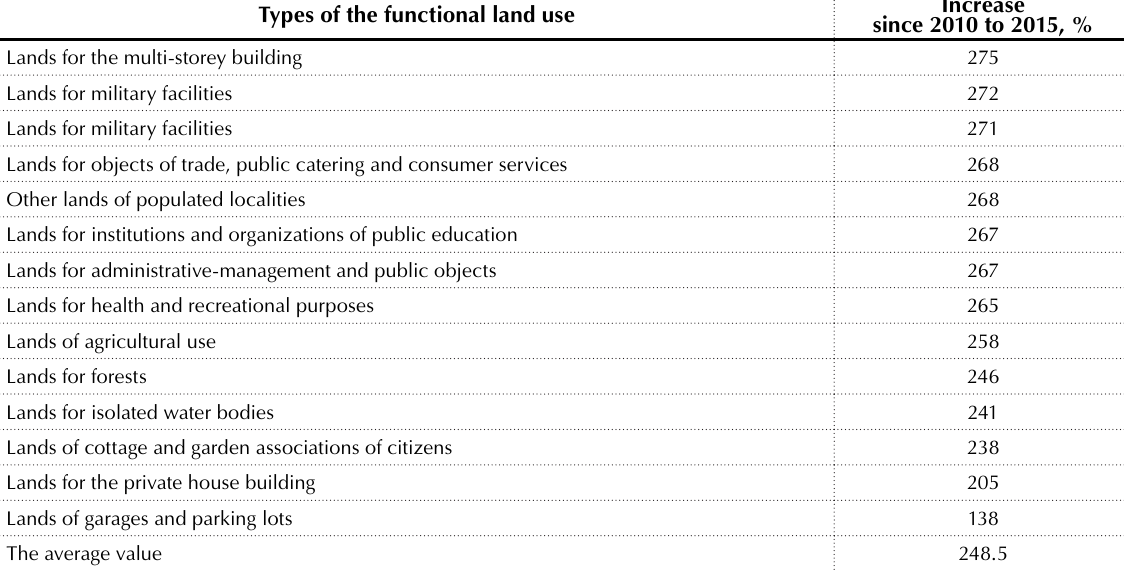
Table 1. Increase at updating the territory of Uman and Uman